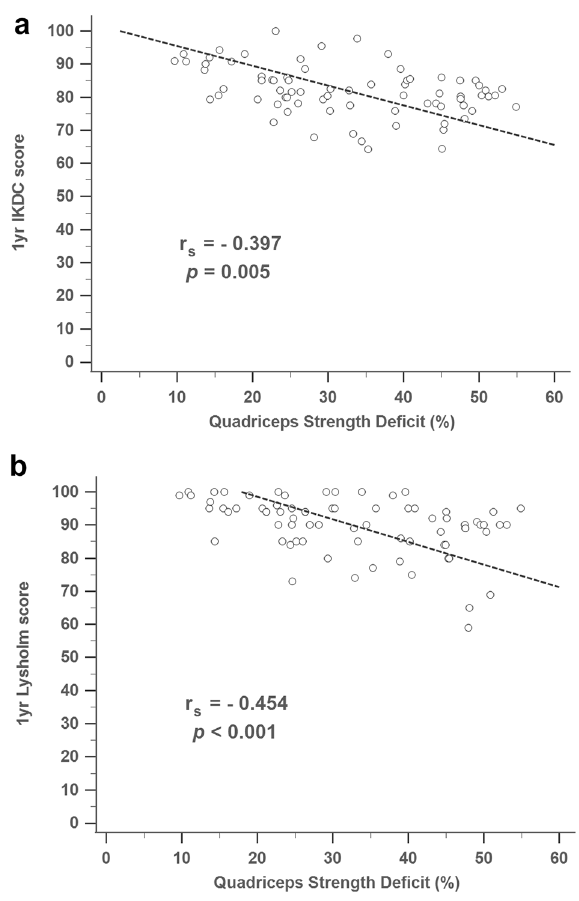
Figure 1. Association between knee extension strength deficit and subjective knee functional score at 1 year. ( a ) IKDC score, IKDC, International Knee Documentation Committee; ( b ) Lysholm